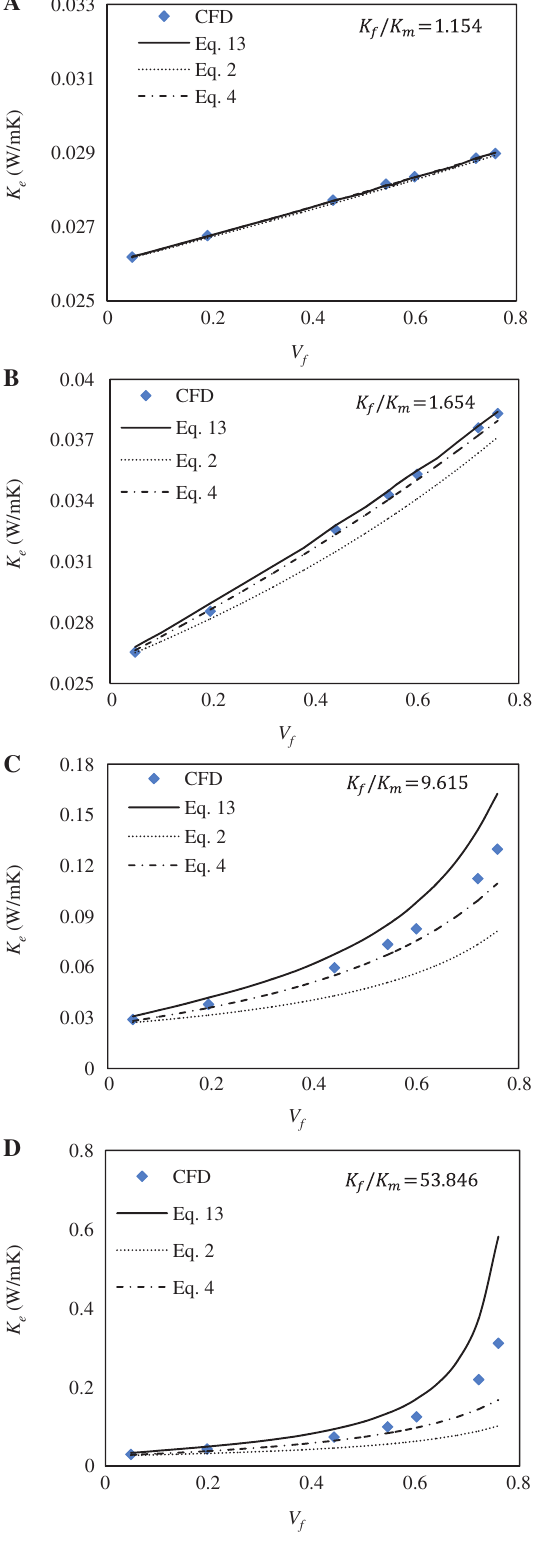
Figure 7 Comparison of predictions by the present model and reviewed models with CFD simulations along V (B) glass fibre/air, (C) nylon6/air and (D) concrete dense